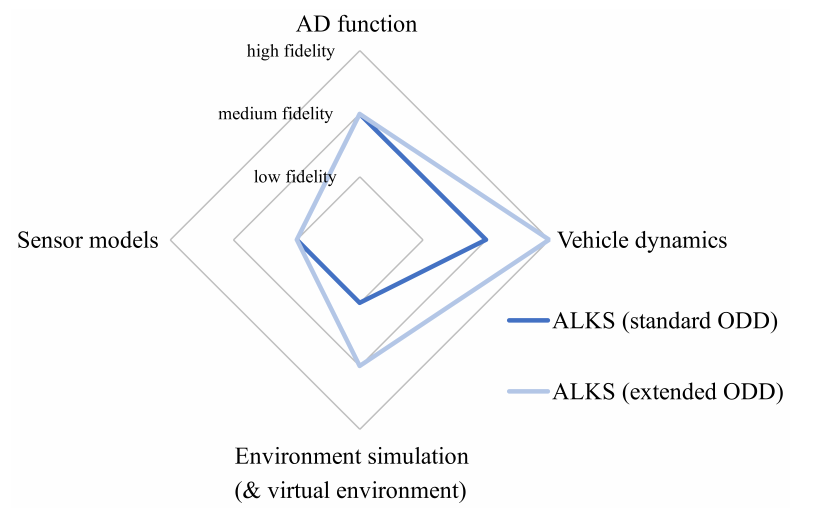
Figure 7. Visual representation of the required model fidelities for the different subsystems of the virtual validation framework.